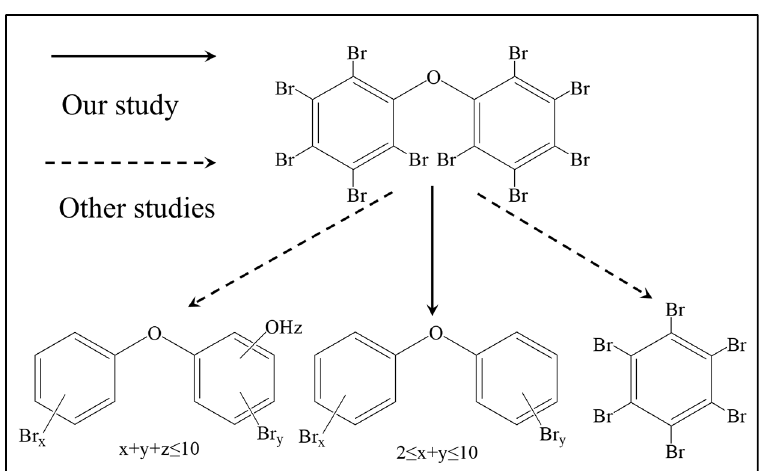
Figure 7. The photodegradation pathways of BDE-209 in soil suspensions.